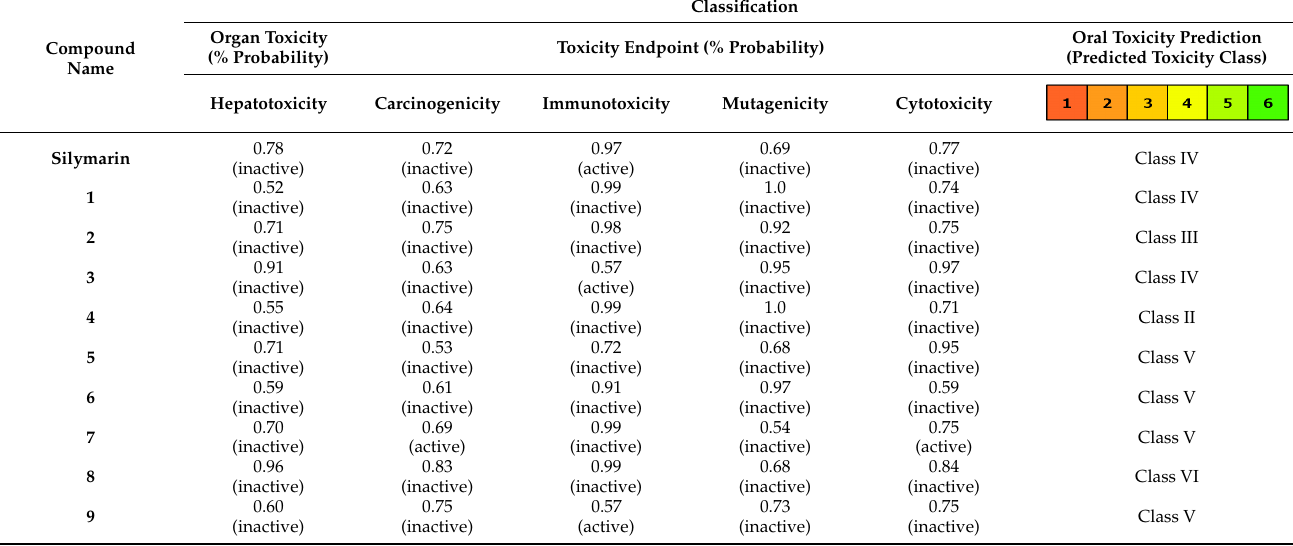
Table 6. Organ and endpoint toxicity predicted using the ProTox-II web server.